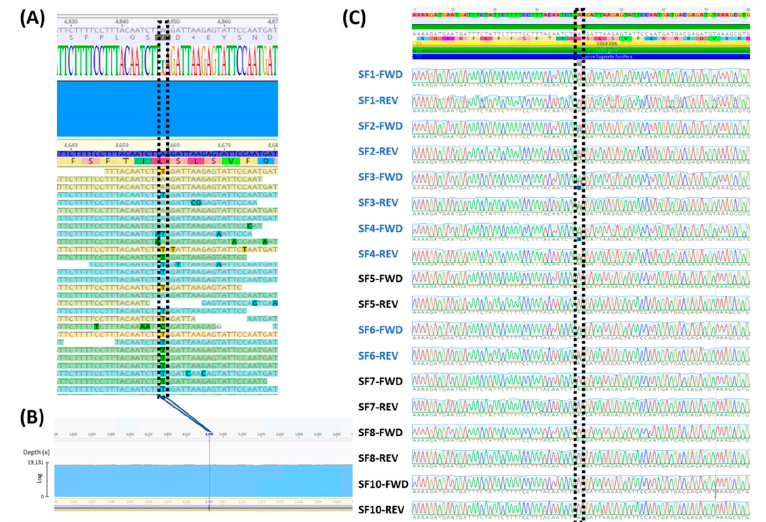
Figure 3. Identification and validation of polymorphic site on WBPHTA mitogenome. ( A ) presents the alignment of NGS raw reads around the polymorphic site on the WBPHTA mitogenome (4667 bp). Consensus bases were displayed as colored base characters. Assembled mitogenome sequences were presented with coordination and coded amino acids. NGS raw reads aligned against the as- sembled mitogenome were displayed under the assembled mitogenome sequences. The block-dot- ted box indicates the polymorphic site. ( B ) exhibited sequencing depth around the heteroplasmy site (4667th). The X-axis indicates coordination of mitogenome and Y-axis presented sequencing depth as log scale. ( C ) shows the alignment of sequencing chromatograms against the WBPHTA mitogenome. Labels at the left side indicate sample name (SF plus number) and sequencing direc- tion (FWD; forward and REV; reverse) together. The block-dotted box indicates the polymorphic site. To confirm whether this polymorphic site contains both bases, we amplified the re- gion around this site of the ten additional individuals (SF1 to SF10) by PCR and sequenced the PCR products using the Sanger sequencing method. We obtained the sequencing re- sults from nine out of ten individuals (Figure 3B), resulting in five out of nine individuals, SF1, SF2, SF3, SF4, and SF6, presenting the polymorphic base, A and T, simultaneously within one individual (Figure 3B). Because of this polymorphic base, base calling results at this site from the five individuals were not consistent (Figure 3B). This result is different from what we expected, namely, that heterogeneous haplotypes from multiple individu- als can cause a ‘virtual’ heteroplasmy phenomenon based on NGS results. However, there was a real heteroplasmy phenomenon in WBPH individuals, and this is the first report of heteroplasmy in the mitochondrial genome of a species in the family Delphacidae. Because this heteroplasmy phenomenon was only observed in WBPH individuals from WBPHTA, a breeding line, has been established and reared in the insectary since 2006, it was necessary to evaluate whether this heteroplasmy in the WBPH mitogenome is also common in wild populations or not. A 4667th nucleotide sequence of COX3 from a total of 24 individuals of the two Korean wild WBPH populations, WBPHHD and WBPHBS, was investigated using PCR and the Sanger sequencing method. In the results, there was no heteroplasmy phenomenon and single nucleotide polymorphism (SNP; only A) at the 4667th of the WBPH mitogenome. It suggests that the heteroplasmy and SNP of WBPHTA mitogenome might be uncommon in the wild WBPH populations in fields. The heteroplasmy of WBPHTA mitogenome would be associated with continuous pressures